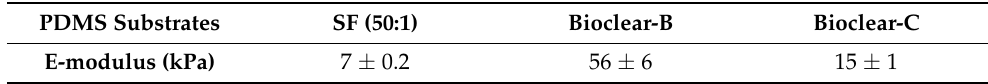
Table 1. Measured elastic moduli of the soft PDMS substrates. PDMS